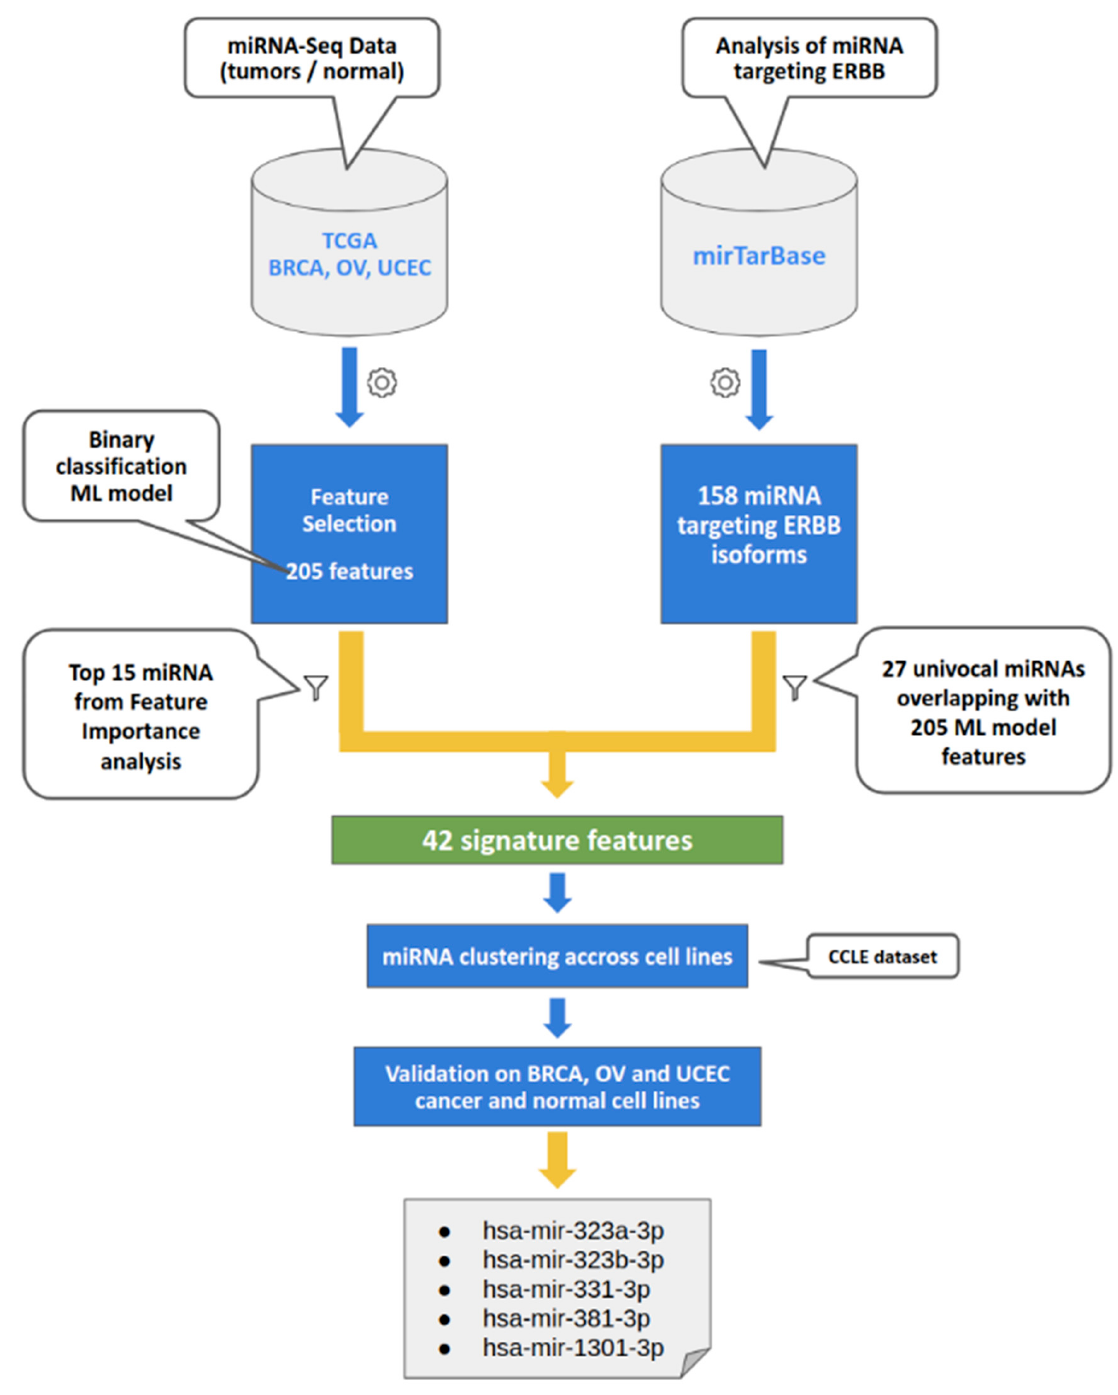
Figure 1. Workflow. The study design encompasses the integration of TCGA miRNA expression data and miRNAs targeting ERBB family genes within a machine learning approach to prioritize common miRNA signatures. Abbreviations: The Cancer Genome Atlas (TCGA), Breast invasive carcinoma (BRCA), Ovarian Serous Cystadenocarcinoma Cancer (OV), Uterine Corpus Endometrial Carcinoma (UCEC), miRNA Target Interaction (miRTarBase) Database, the Cancer Cell Line Encyclopedia (CCLE) dataset (PRJNA523380), miRNA expression dataset. To this end, we queried two bioinformatics resources: (i) the TCGA, a genomic data-